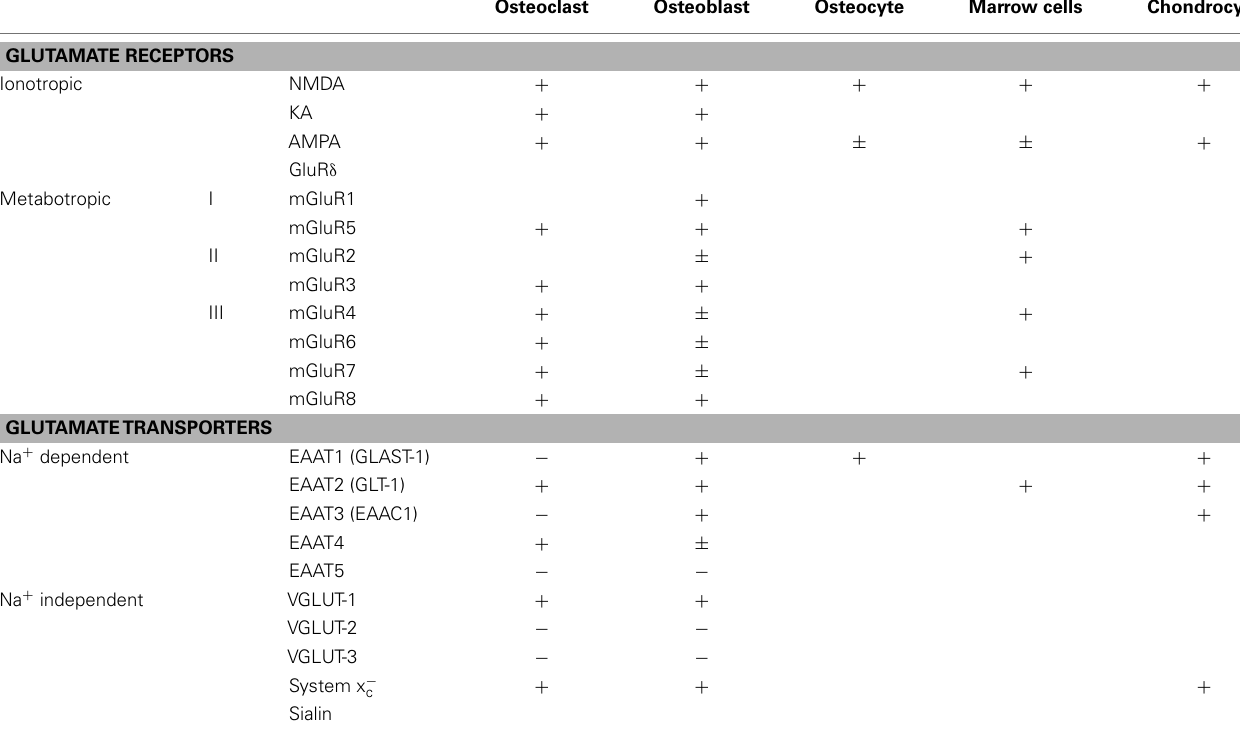
Table 1 |A summary of glutamate signaling components expressed by normal bone